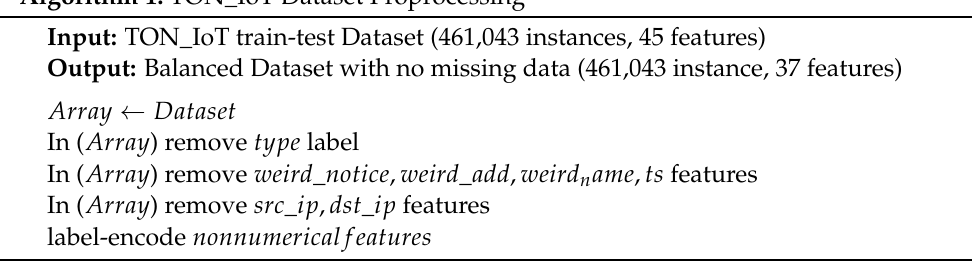
Algorithm 1: TON_IoT Dataset